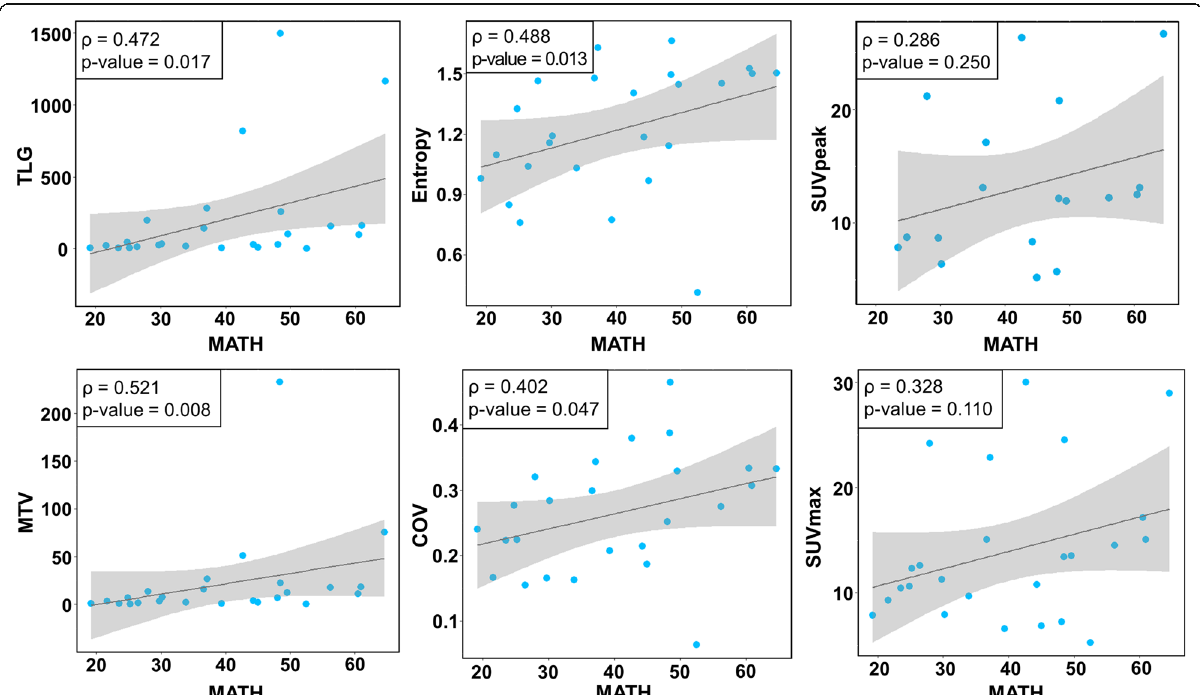
Fig. 2 Correlation between MATH and FDG PET features. Scatter plots for correlation analysis of MATH and FDG PET features. Each blue dots represent patients available for MATH and radiomic data ( N = 25). Upper left box shows Spearman correlation coefficient ( ρ ) and P value. The dark gray line means a linear regression line and the gray region is 95% confidence